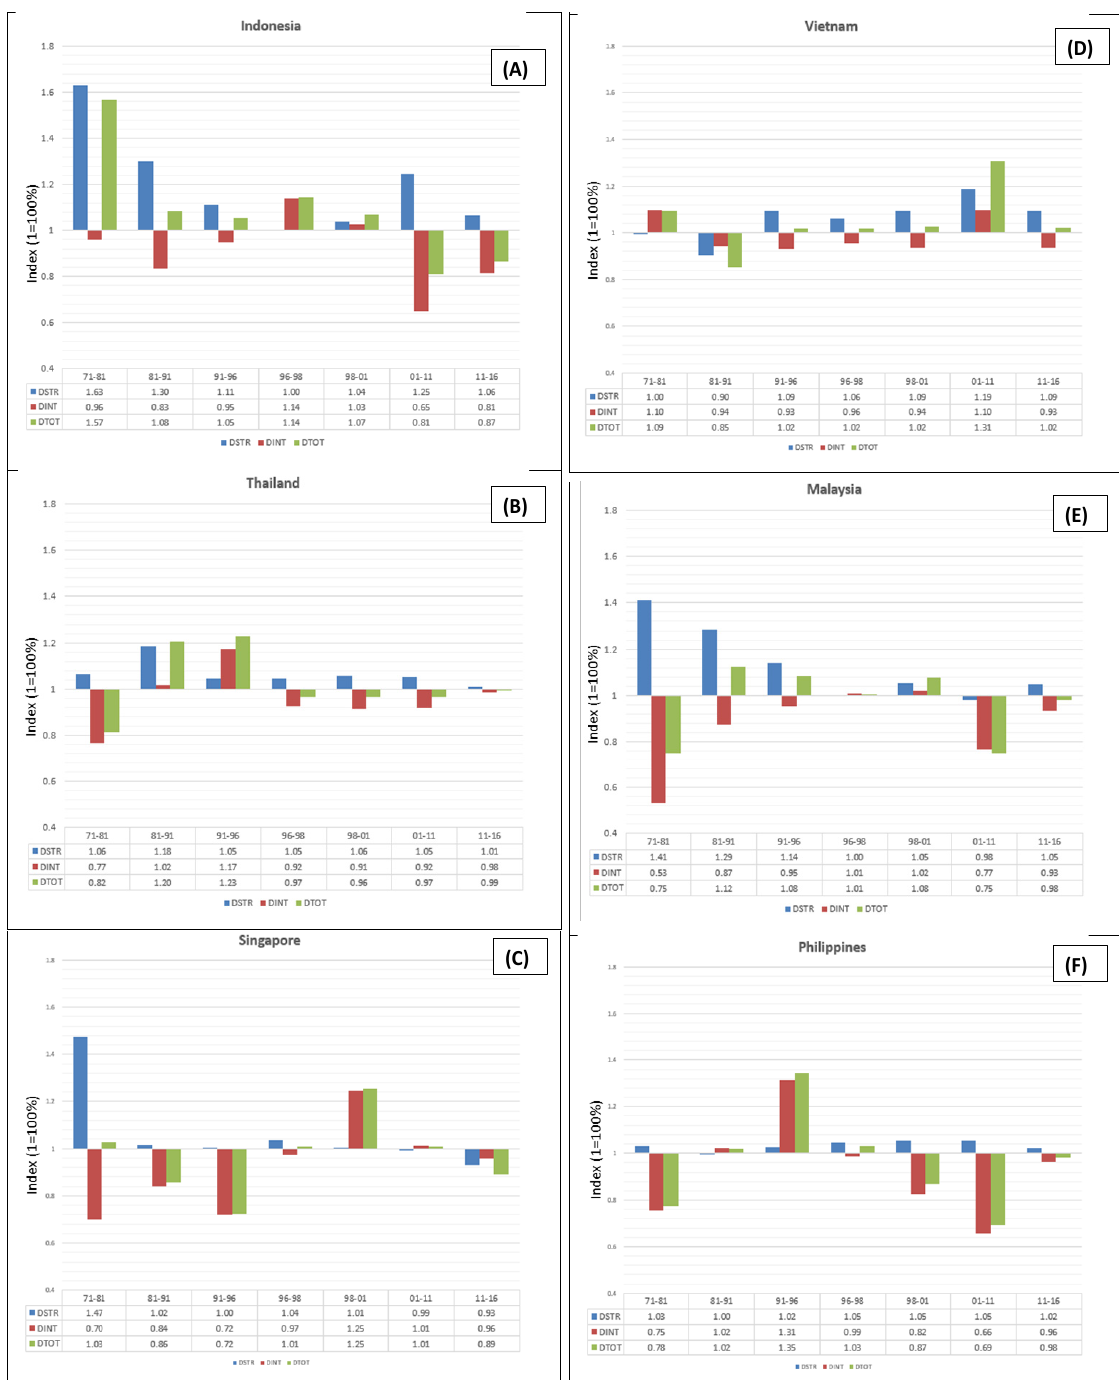
Fig. 2: Period wise energy intensity decomposition (A, B, C, D, E and F)